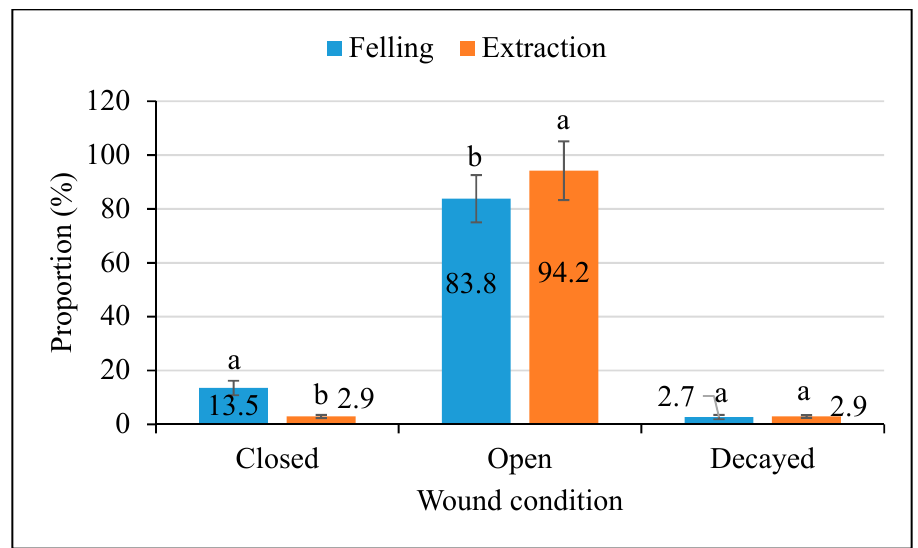
Figure 4. Condition of felling and extraction wounds three years after wound occurrence.